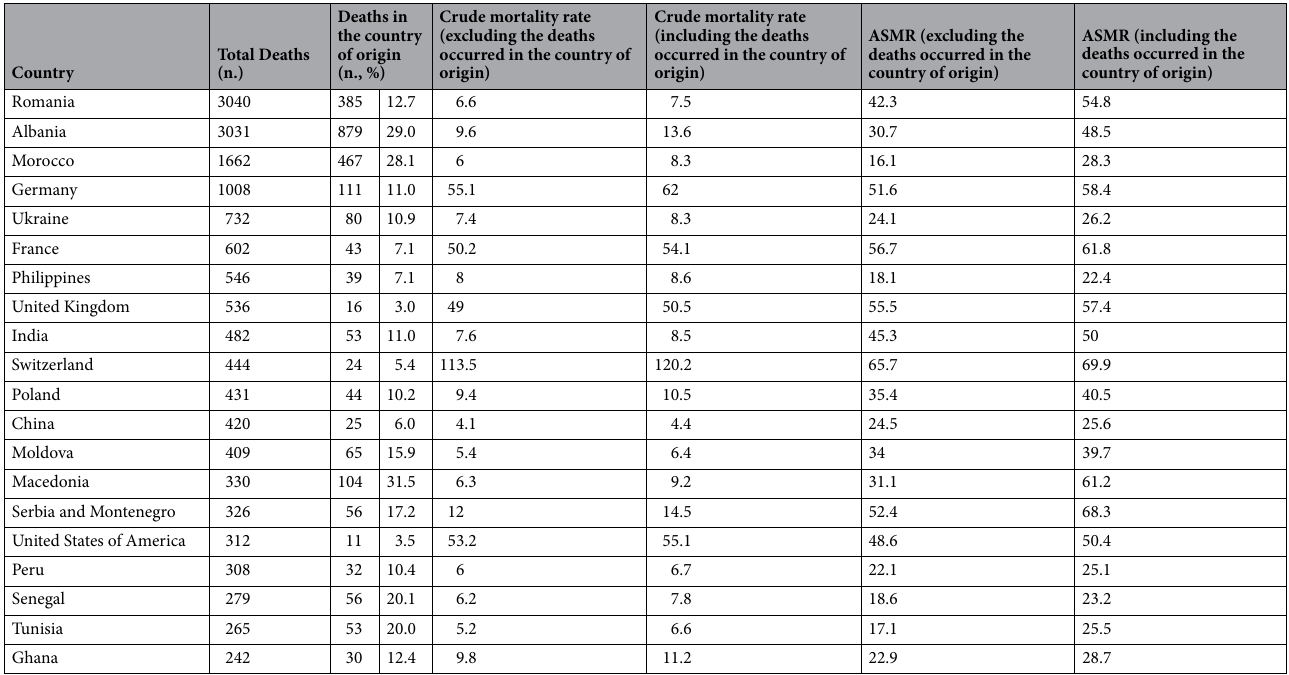
Table 1. Total deaths, crude and age-standardized mortality rates (ASMRs) (per 10,000 person-years) among immigrants resident in Italy, calculated with and without the deaths occurred in the country of origin, by country. Data are shown only for the 20 countries with the highest number of deaths registered in the period 2012–2016.